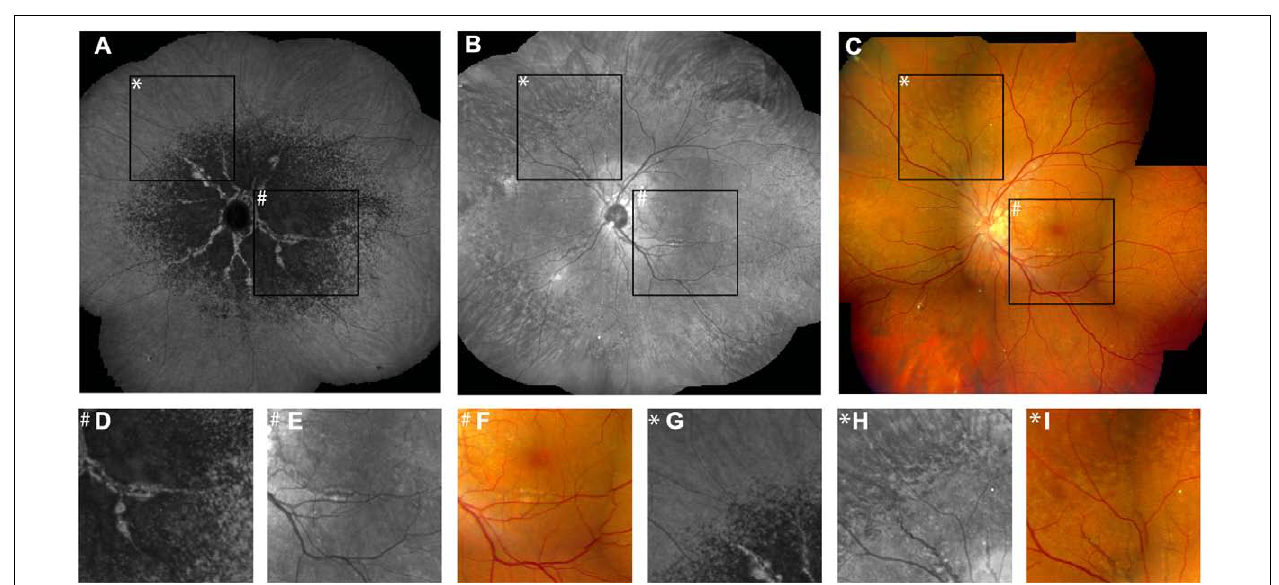
FIGURE 5 | Comparison of findings on late phase ICG angiography, NIR reflectance imaging and funduscopy. The transition zone from reduced to normal fluorescence on ICG angiography (A) is located more centrally relative to peau d’orange (B,C) . Note that there is no correlate of this phenomenon on IR reflection imaging or funduscopy (D–F) . Non-invasive near-infrared (NIR)